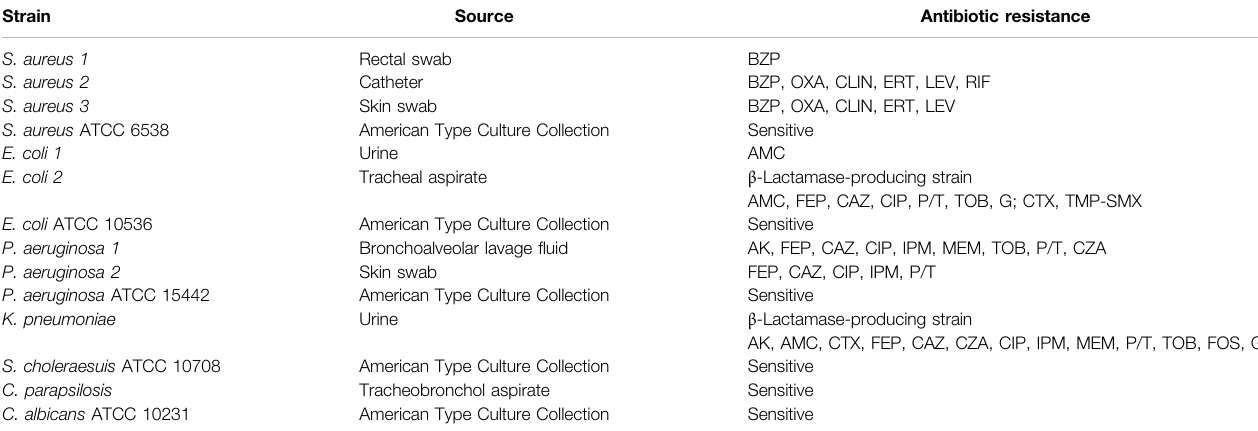
TABLE 1 | Antibiotic resistance pro fi le of microbial